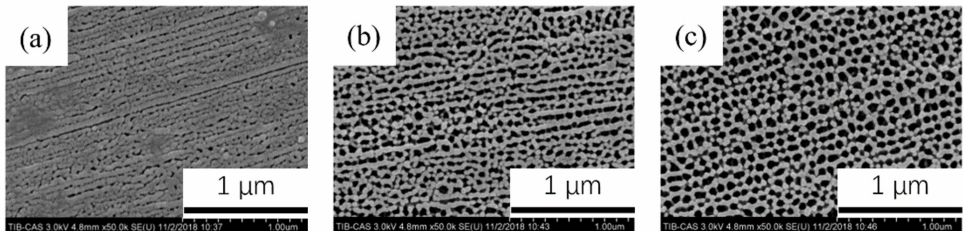
Figure 5. SEM images of 1060 anodic oxide films at different anodic oxidation temperatures: ( a ) 3 °C; ( b ) 21 °C; ( c ) 26